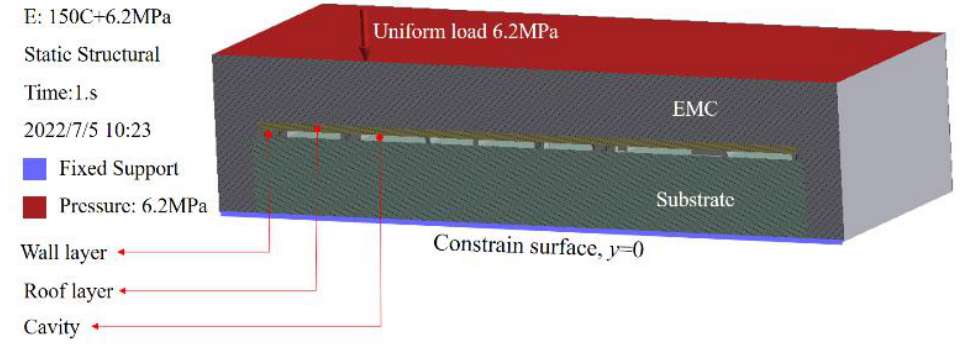
Figure 11. Collapse model and boundary conditions.